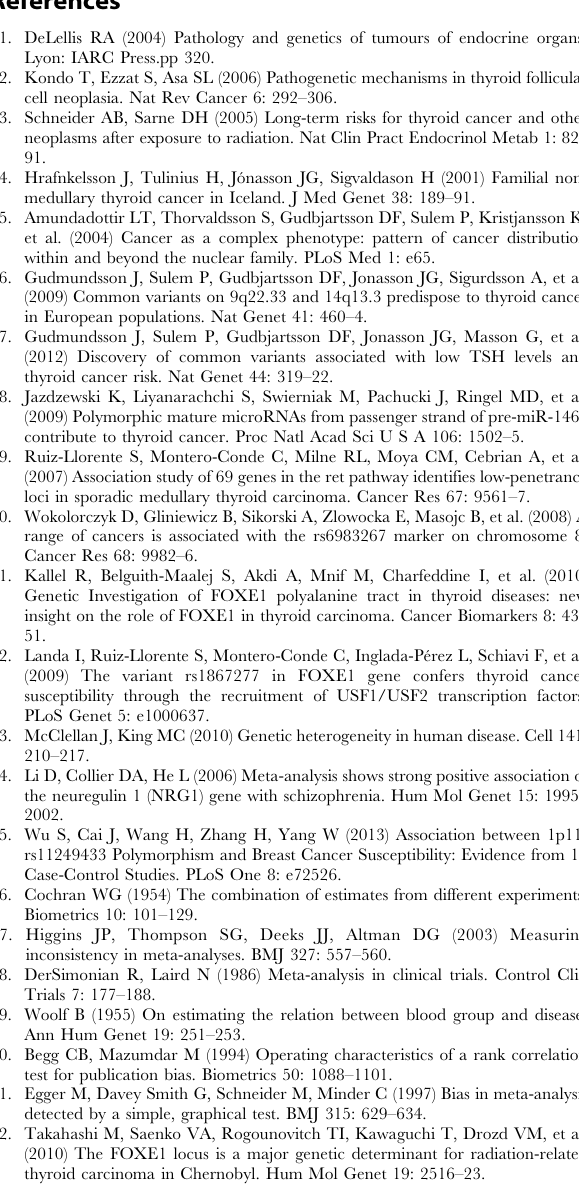
Figure S8 Begg’s funnel plot for publication bias in studies on FOXE1 rs965513 polymorphism and thyroid cancer. Figure S9 Begg’s funnel plot for publication bias in studies on FOXE1 rs1867277 polymorphism and thyroid cancer. Figure S10 Begg’s funnel plot for publication bias in studies on FOXE1 rs71369530 polymorphism and thyroid